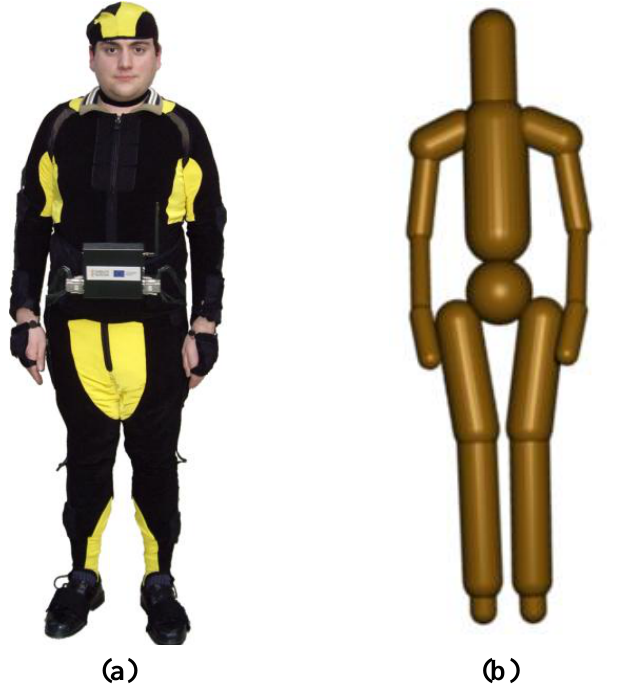
Figure 2. Safety system for human operators: (a) Human Tracking system; (b) Bounding